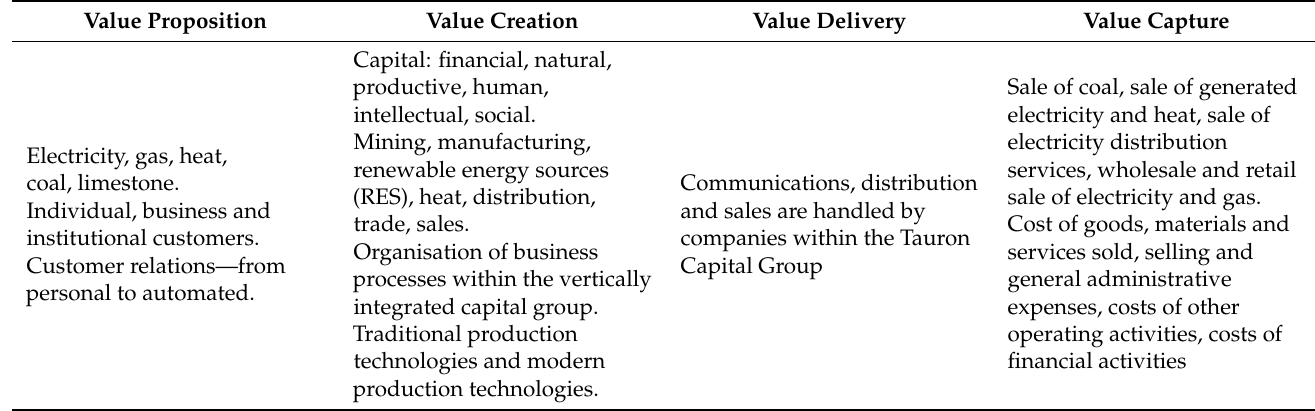
Table 1. Tauron Capital Group—business